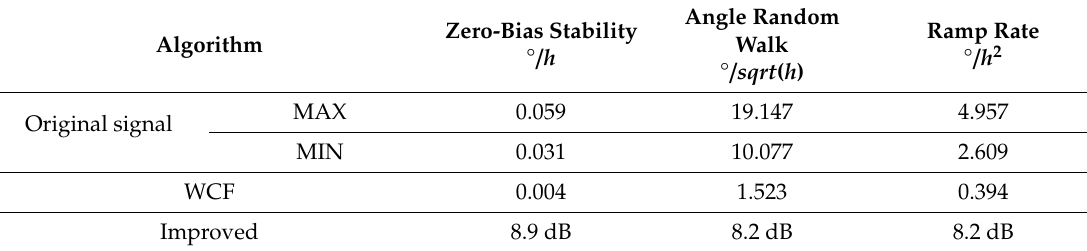
Table 2. Optimization results of roll angle (north) error.